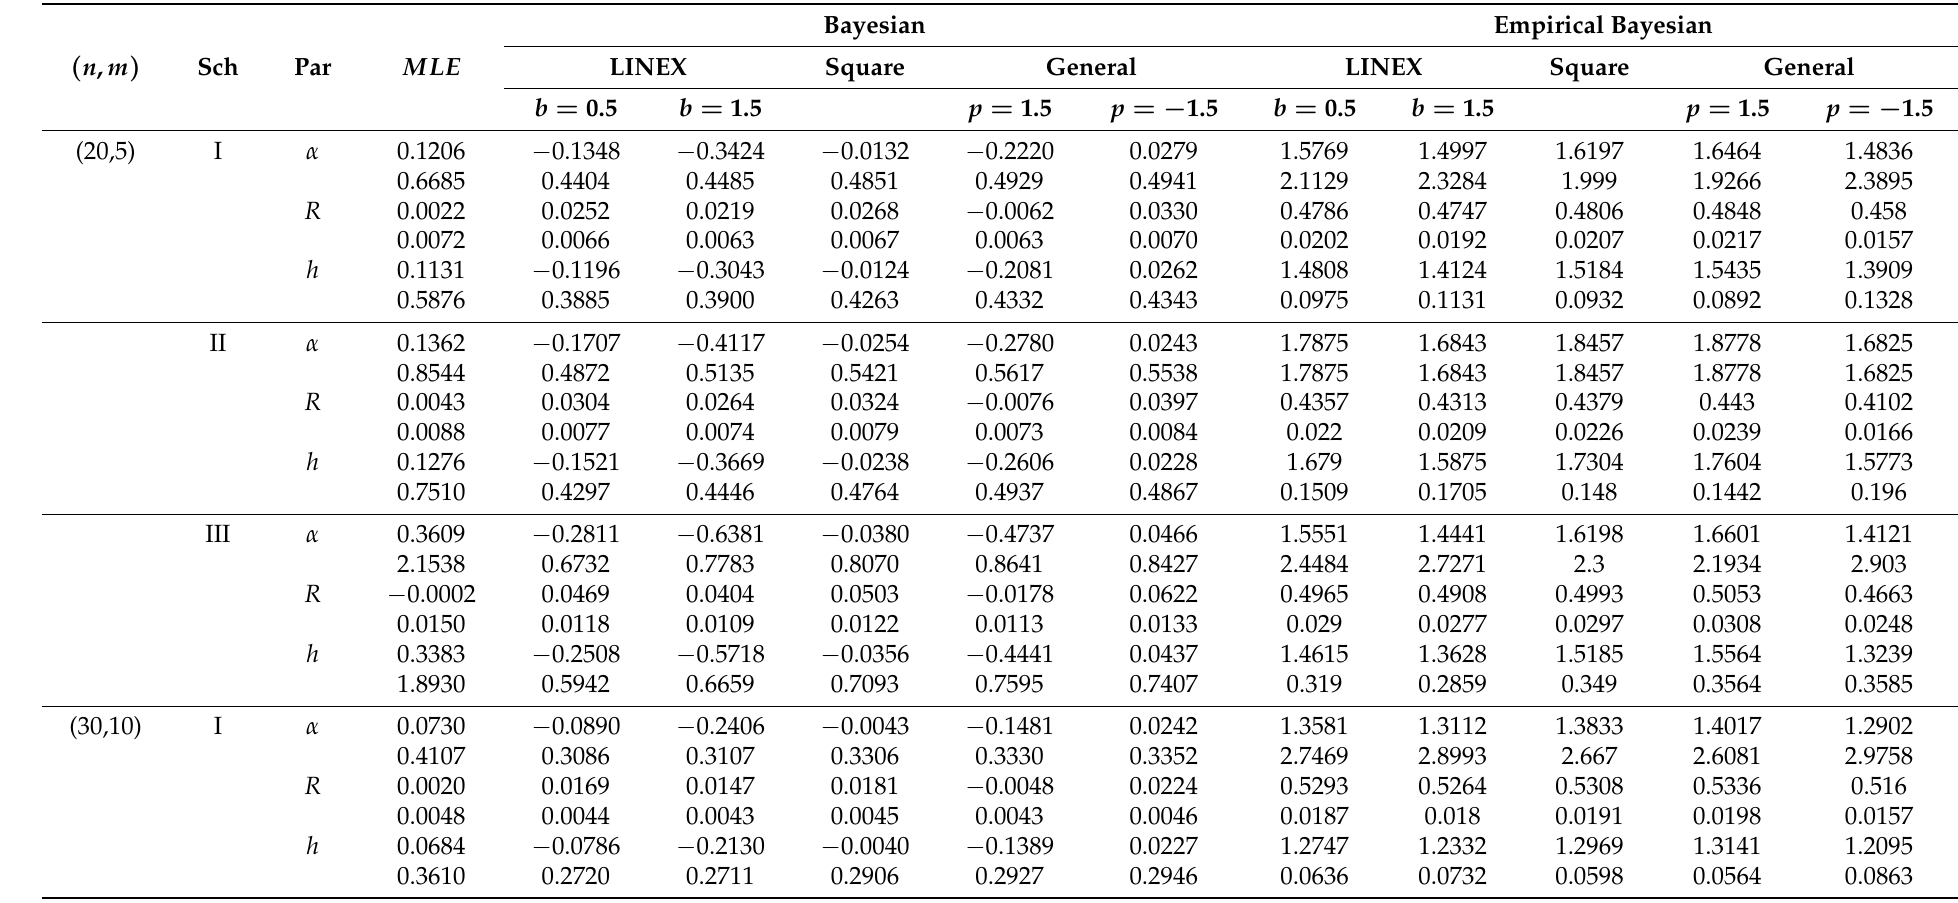
Table 1. Simulated biases (first row) and MSEs (second row) under different settings with α = 3.0, β = 1.5, τ = 0.5 and ω =